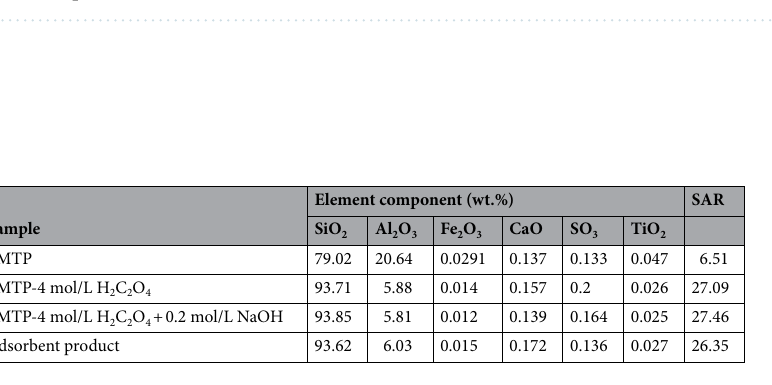
Table 2. Composition and content of adsorbent products.